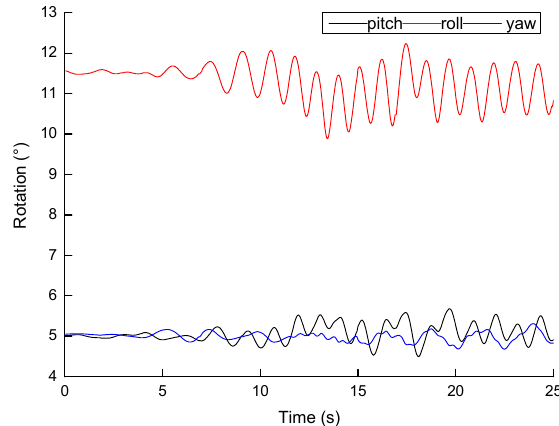
Figure 15. The angle variations of scheme 2 in the mooring experiment.